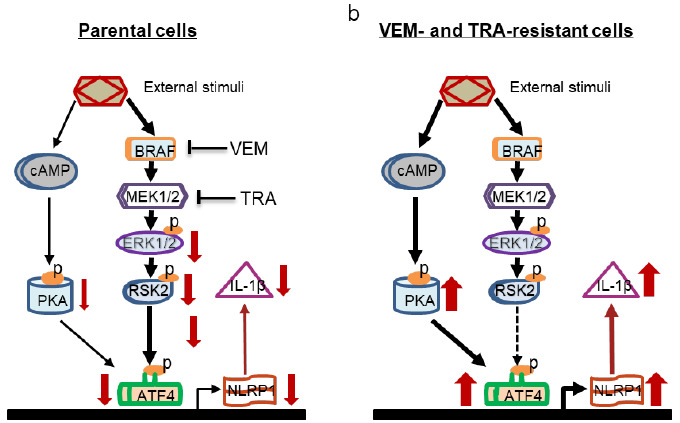
Figure 6. Hypothetical roles of ATF4/NLRP1 in acquired targeted therapy resistance in melanoma. ( a ) ATF4/NLRP1 in parental melanoma cells. Red arrows indicate the inhibitory effects of VEM and TRA. Bars indicate inhibition. ( b ) ATF4/NLRP1 in resistant melanoma cells. Red arrows indicate the upregulation of expression levels. A dashed line indicates a signal loss. In both a and b, the thickness of red arrows indicates relative expression levels; the thickness of black arrows indicates the relative strength of signaling pathways; and “p” in orange oval indicates phosphorylation.